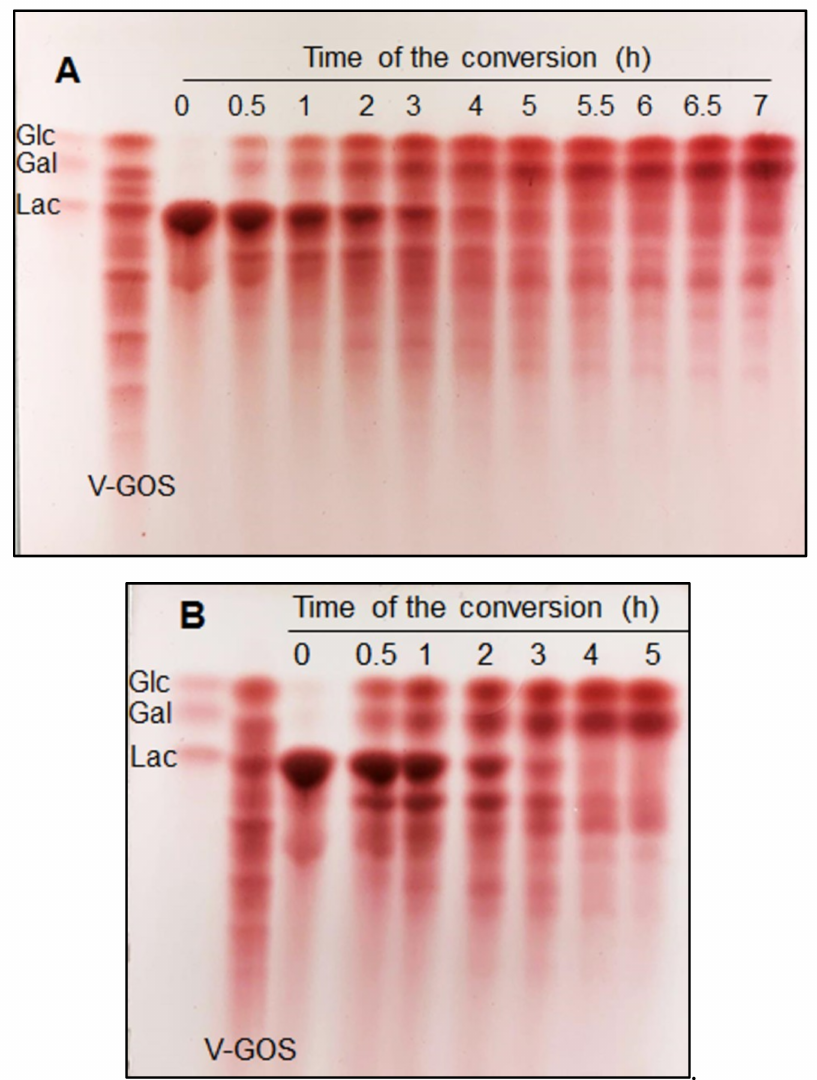
Figure 5. Hydrolysis of lactose catalyzed by recombinant β -galactosidases from L. helveticus , ( A ) crude enzyme Lp609Lh β -gal and ( B ) purified EcoliBL21Lh β -gal, as analyzed by thin layer chromatography (TLC) on pre-activated silica plates (eluent n -butanol/ n -propanol/ethanol/water mixture: 2/3/3/2). The reactions were carried out at 50 ◦ C with an initial lactose concentration of 205 g L − 1 in 50 mM sodium phosphate buffer (pH 6.5) containing 1 mM MgCl 2 and 1.5 U Lac mL − 1 of